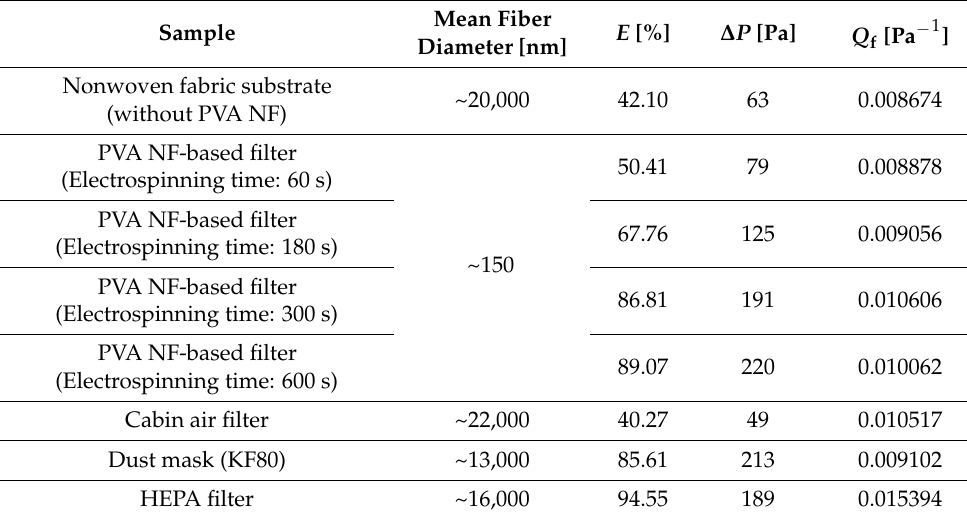
Table 1. Measured average fiber diameter, filtration efficiency, pressure drop, and calculated quality factor of PVA NF-based filters and commercial air filters used in this